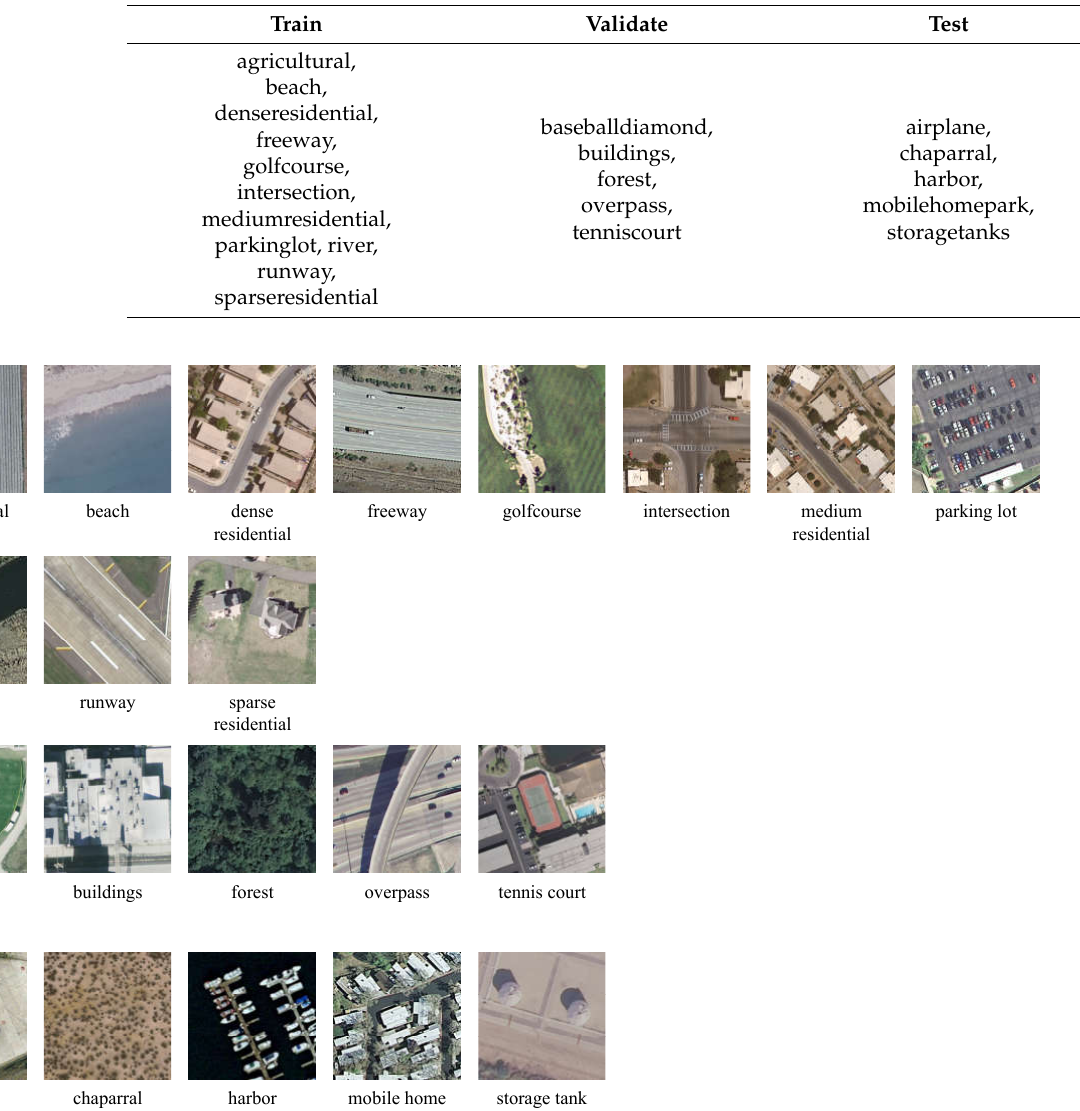
Table 1. Class segmentation for the UCM dataset.